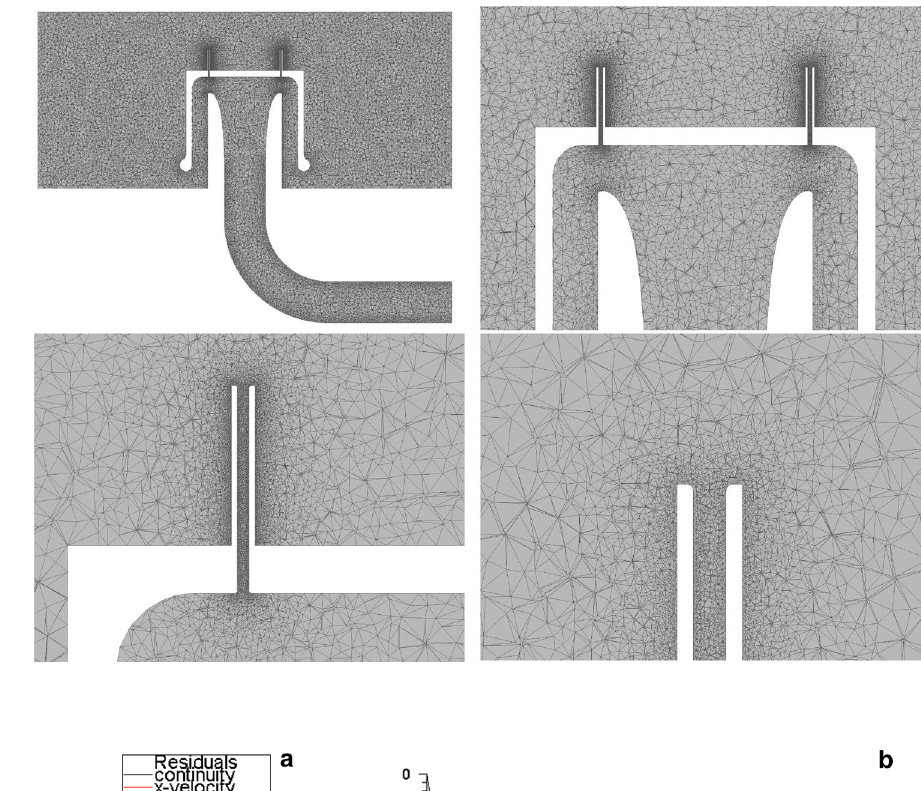
Fig. 2 Mesh structure of the numerical